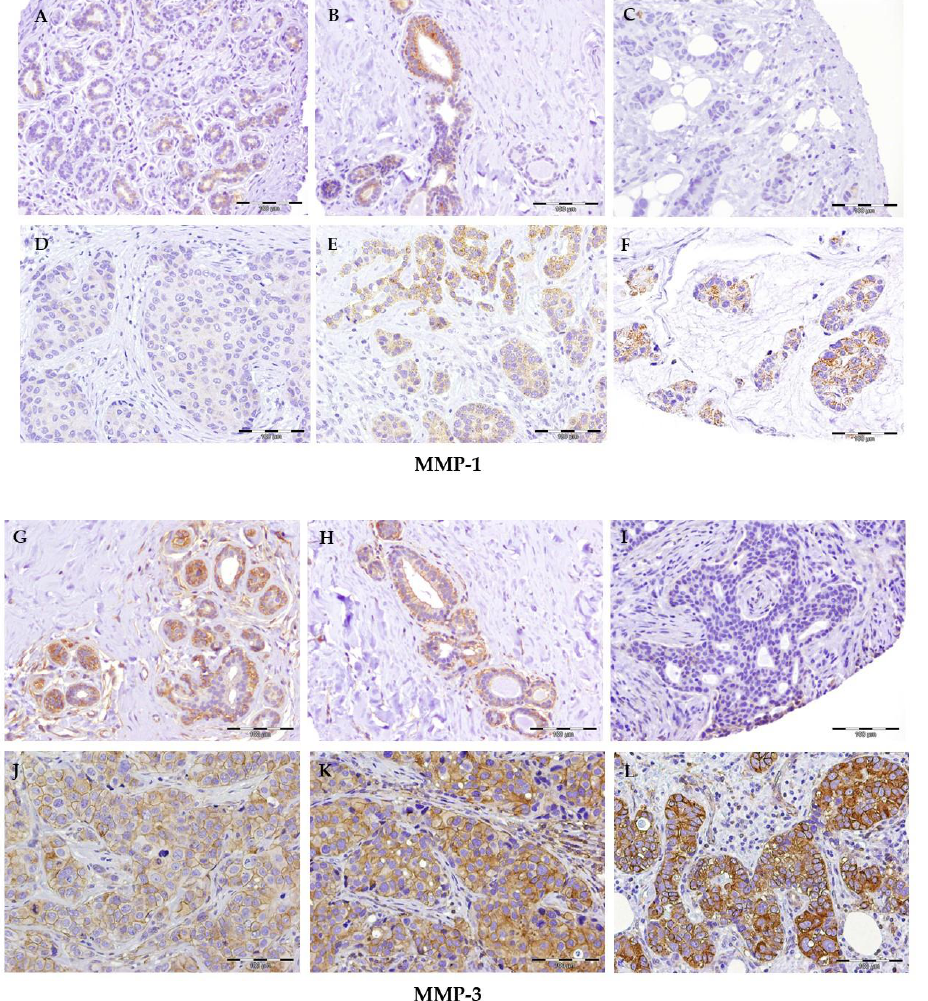
Figure 1. Immunostaining of MMP-1 (ABCAM, ( A – F )): ( A , B ) sections of normal breast tissue; ( C – F ), sections of breast carcinoma with different level of staining intensity; ( C ) absence of staining; ( D ) weak staining; ( E ) moderate staining; ( F ) intense staining. Immunostaining of MMP-3 (AGENT, ( G – L )): ( G , H ) sections of normal breast tissue; ( I – L ) sections of breast carcinoma with different levels of staining intensity; ( I ) absence of staining; ( J ) weak staining; ( K ) moderate staining; ( L ) intense staining. The length of the scale bar is 100 μm.